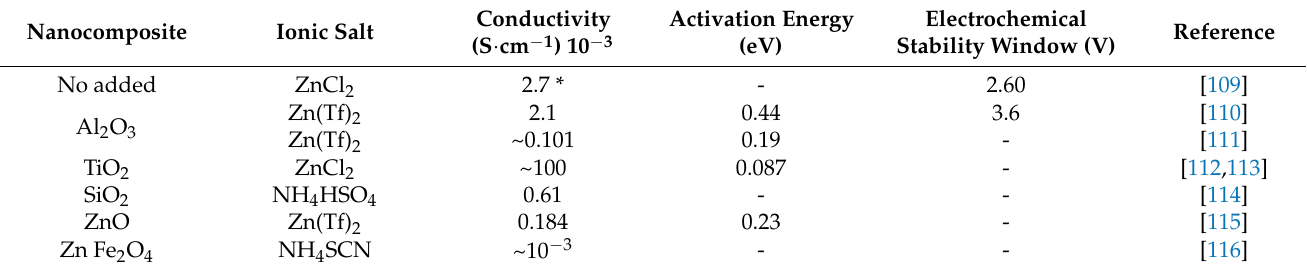
Table 4. A summary of NCPEs composed of PEO for zinc batteries in